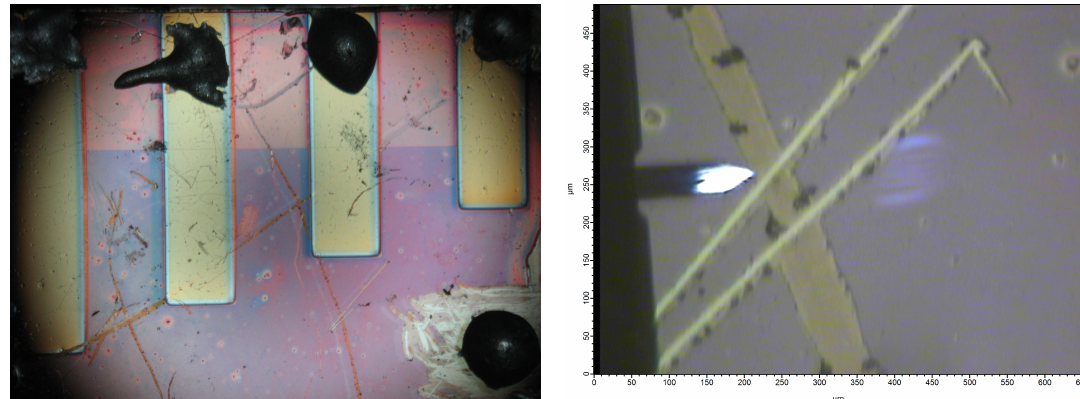
Figure 3. On the left, an optical microscopy image of one the prototypes captured with a Zeiss Stereo Discovery.V12 microscope. On the right, a SEM image of a scratched